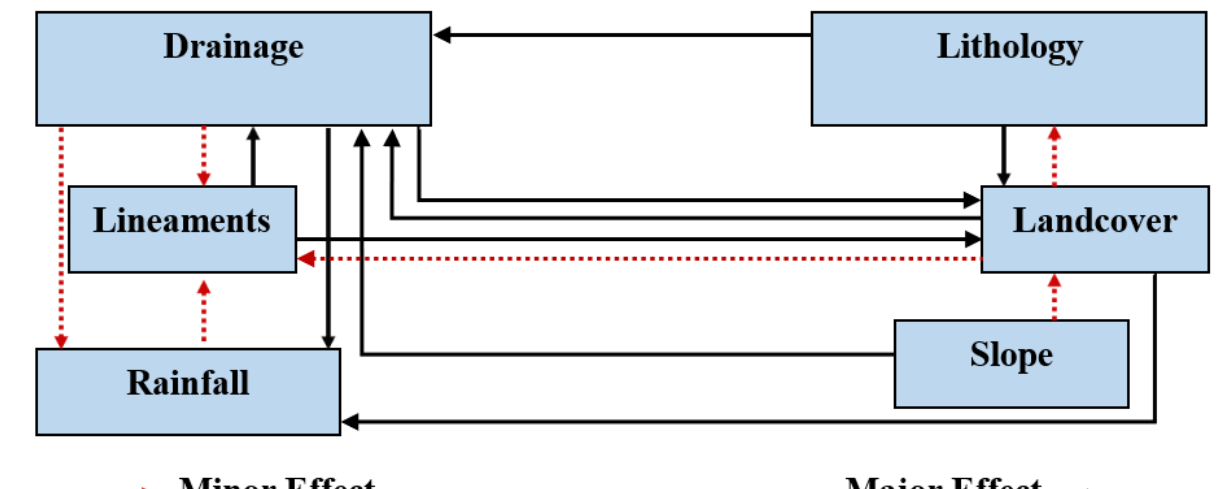
Figure 5. The interactive influence of the selected factors.